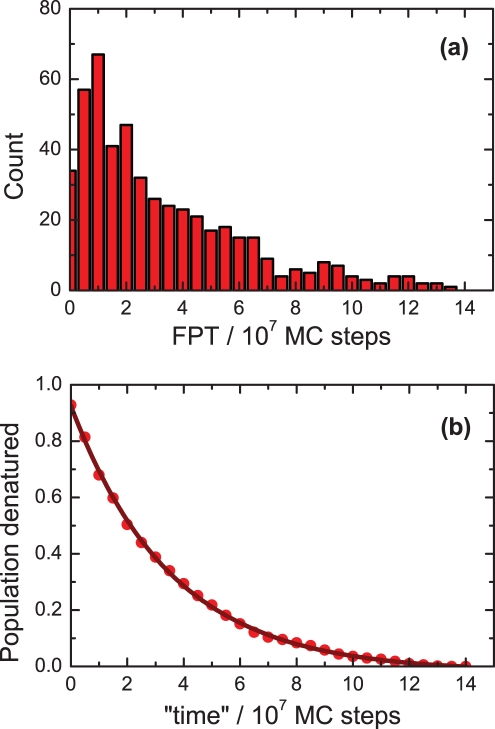
(a) Distribution of the first passage times of folding (FPT) for the 500 independent trajectories of a given CP. (b) "Time" evolution of the denatured state population, obtained by integration of the histogram in the upper graph. The solid line corresponds to the fitting to a single exponential decay.